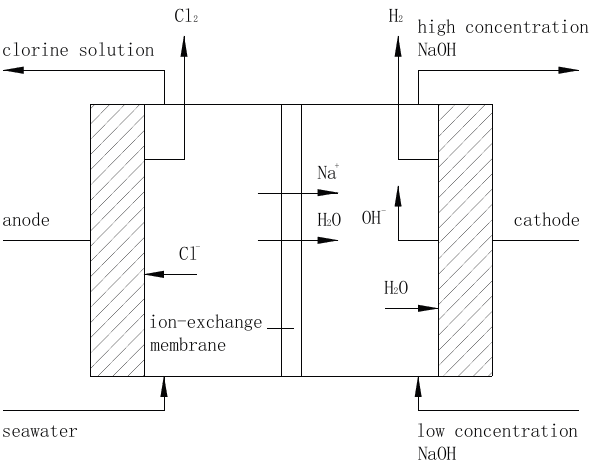
Figure 5. The operating principle of ion-exchange